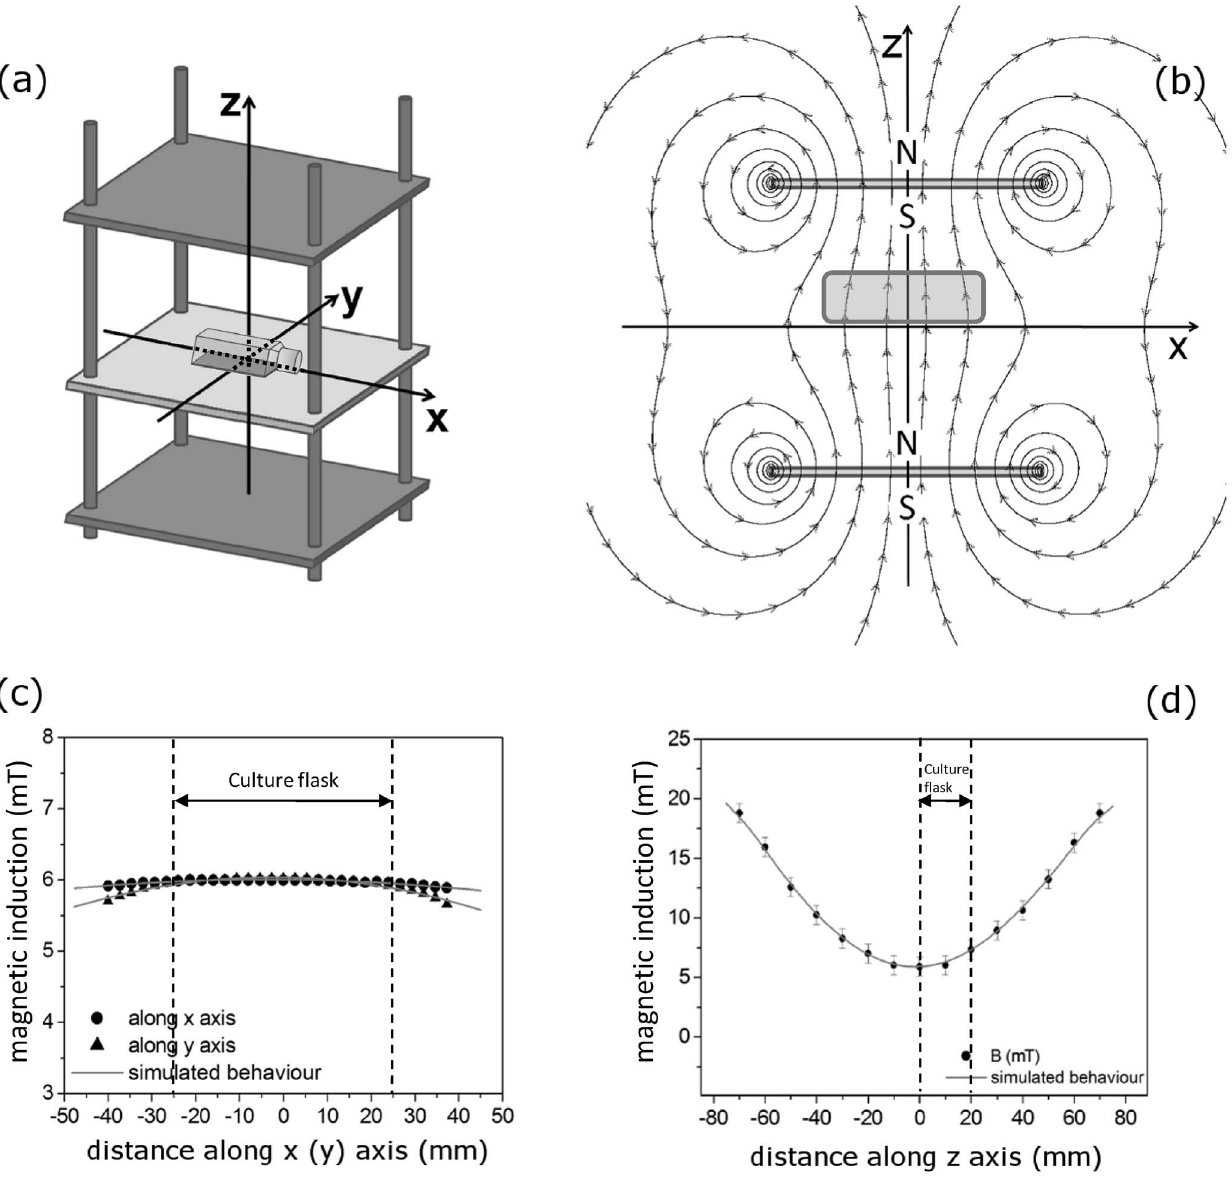
Figure 1. Exposure to SMF by using the Magnetostatic Field System for Exposure of Cell cultures (MaFiSEC). Schematic representation, not in scale, of (a) culture flask SMF-exposed with the MaFiSEC. The centre of the bottom of the culture flask has been designated as the origin ‘0’ of the reference system; the x and y axes were arbitrarily chosen, and the z-axis is perpendicular to flask and outgoing up from the same flask. The magnetic field is schematically represented by magnetic field lines, showing the direction of the field at different points (b). The filed lines crossing the sample are representative, schematic, i.e., they do not refer to measures of magnetic flux actually measured. (c, d): magnetic induction measured (spots) and simulated (continuous grey line) along (c) the flask and (d) in the perpendicular direction respectively. Error bar represents the SE of six independent experiments, each done in duplicate.